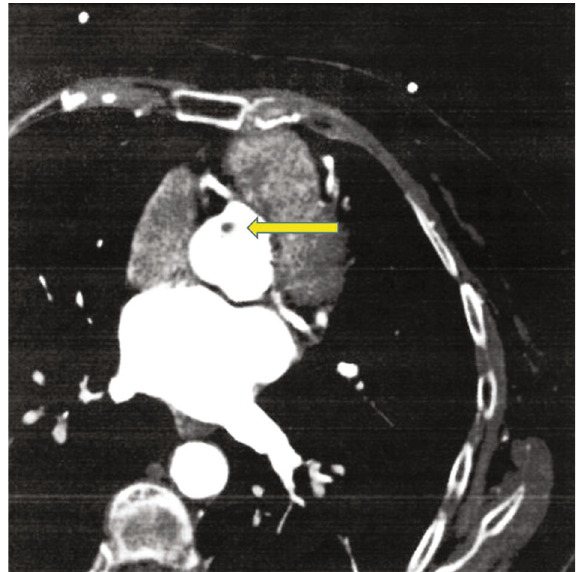
Figure 1: Computed tomography of the heart: the yellow arrow indicates the small round mass located on the right coronary cusp, 11 mm in diameter. Note the origin of the right and left coronary